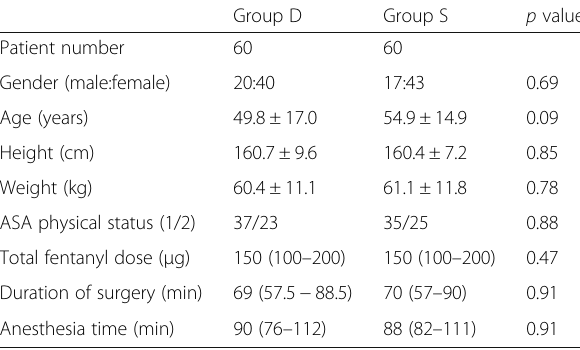
Table 2 Patient characteristics and operation/anesthesia details in both groups